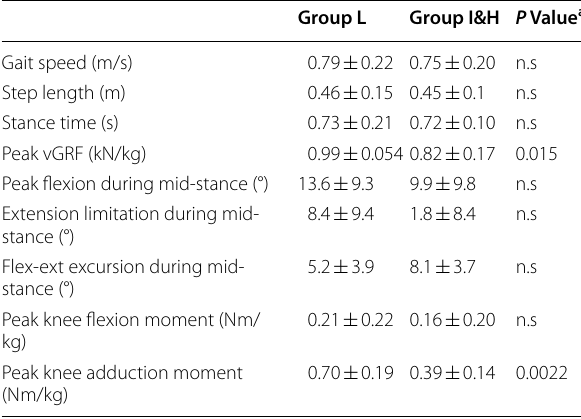
Table 4 Gait parameters in each group based on PD-Q